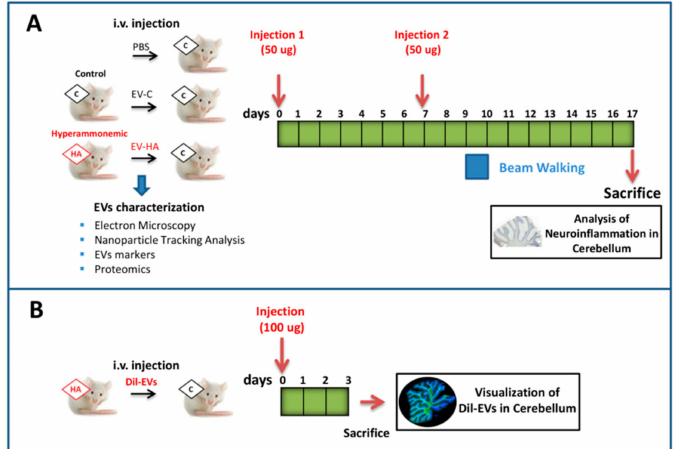
Figure 1. Experimental design. ( A ) Extracellular vesicles from plasma of control and hyperammonemic rats were isolated and characterized by electron microscopy, nanoparticle tracking analysis, extracellular vesicles (EVs) markers, and proteomics. Then, we intravenously injected EVs either from control or hyperammonemic rats (HA) rats into control rats. A third group received only PBS injection. Two injections of 50 µ g each were performed on day 0 and day 7. Beam Walking test was performed at day 9 to study motor incoordination. Rats were sacrificed at day 17 and cerebellum was collected for neuroinflammation analysis. ( B ) In a parallel experiment, we injected fluorescently labeled EVs from HA rats into control rats. Rats were sacrificed after 3 days and cerebellum was collected to assess if fluorescent EVs reach this